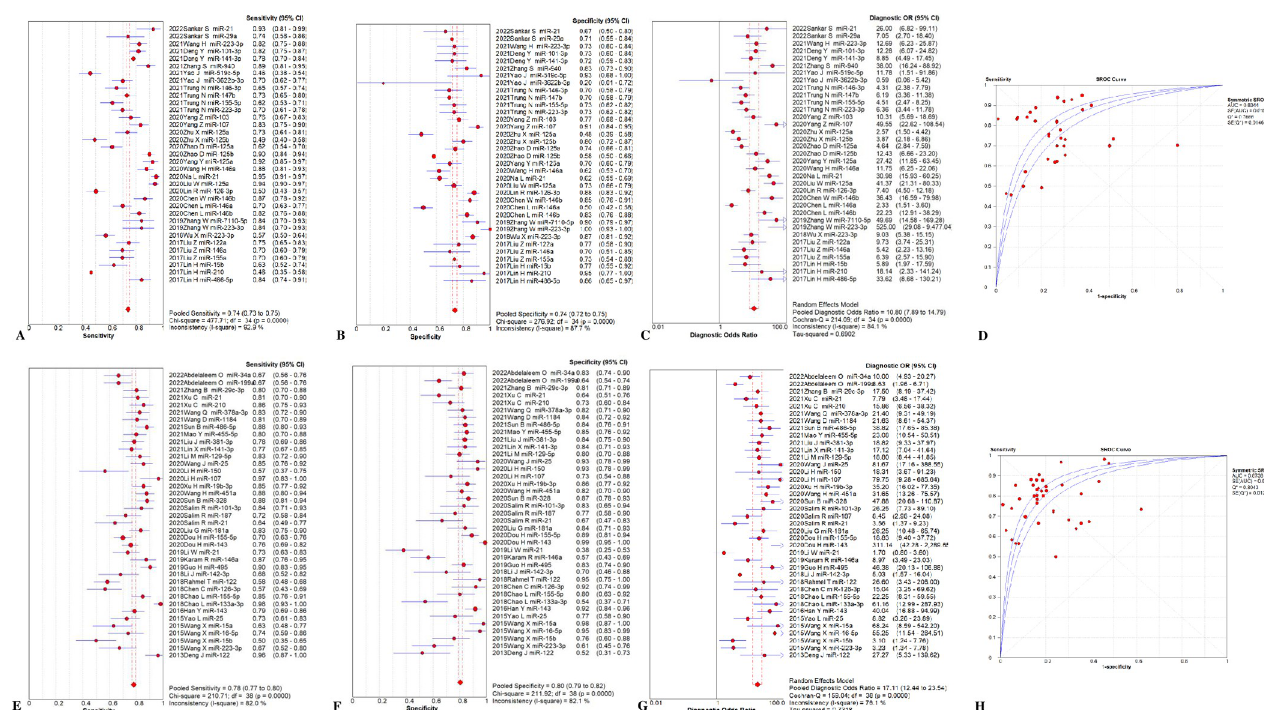
Fig 4. Performance of type of samples detection for sepsis diagnosis. (A) Pooled sensitivity of plasma. (B) Pooled specificity of plasma. (C) Overall DOR of plasma. (D) The SROCs of plasma. (E) Pooled sensitivity of serum. (F) Pooled specificity of serum. (G) Overall DOR of serum. (H) The SROCs of serum. CI = confidence interval, DOR = diagnostic odds ratio, miR = mircoRNA, OR = odds ratio, SROC = summary receiver operating characteristic curves value.